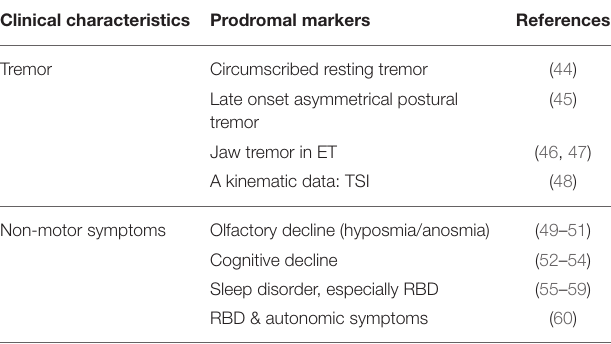
TABLE 3 | Clinical characteristics which can predict the risk of ET patients developing into PD. Clinical characteristics Prodromal